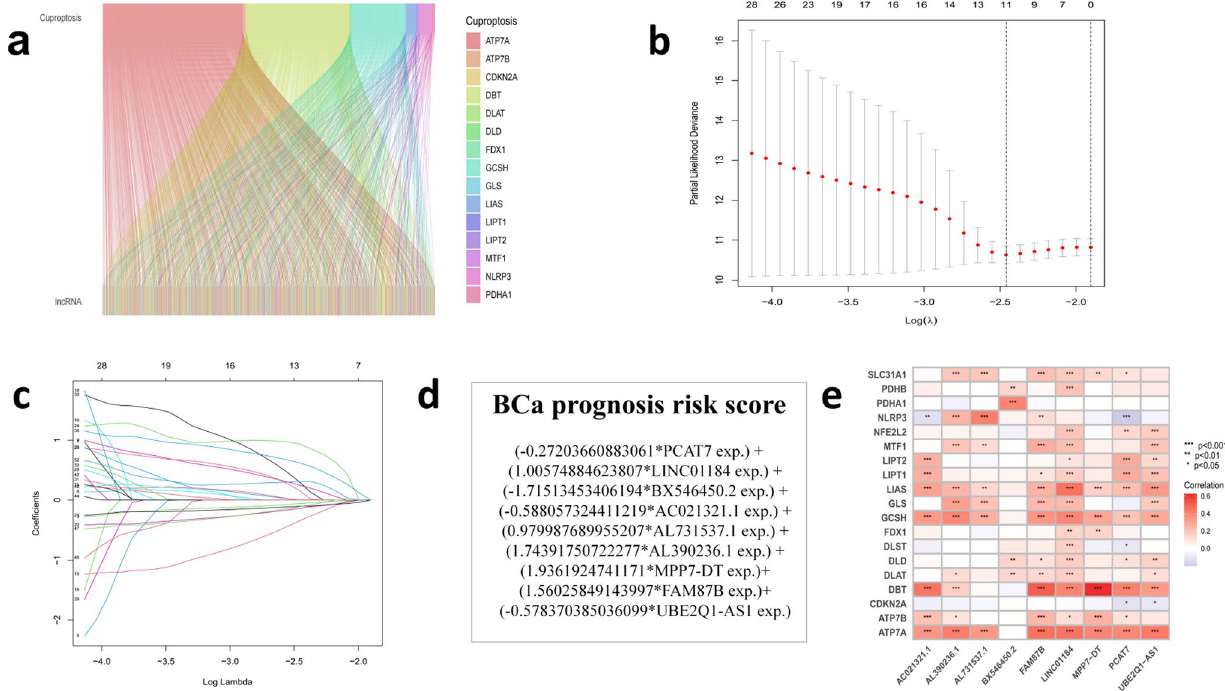
Fig. 2 A screen of differentially expressed cuproptosis-related lncRNAs In bladder cancer a Co-expression analysis results show the correla- tion between cuprotosis-related genes and lncRNAs. b , c LASSO cox regression for the prognostic value of the cuprotosis-related lncRNAs. d CRLs risk model formula. e The heat map indicated a correlation between the 19 cuproptosis-related genes and 9 signature